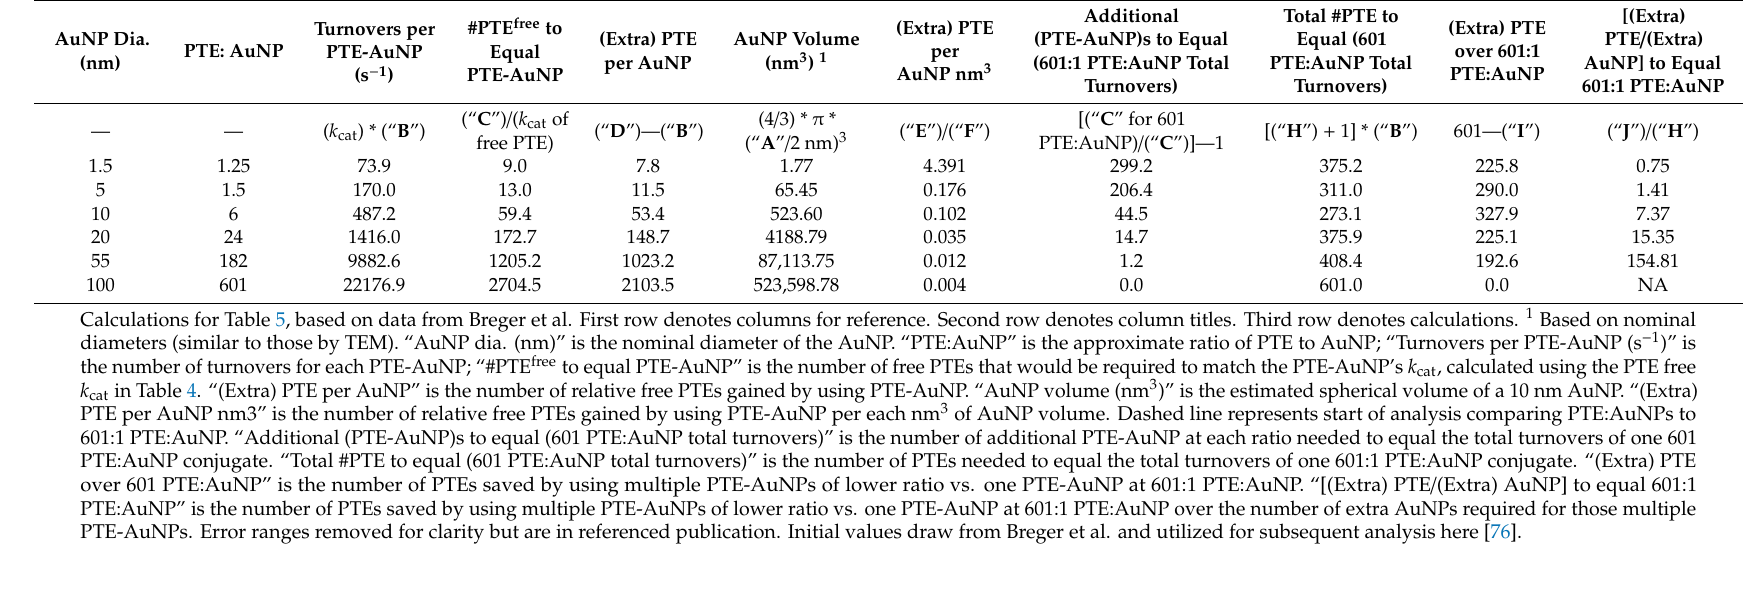
Table A2. Averaged enzyme activities for fixed enzyme density format for low coverage conditions.